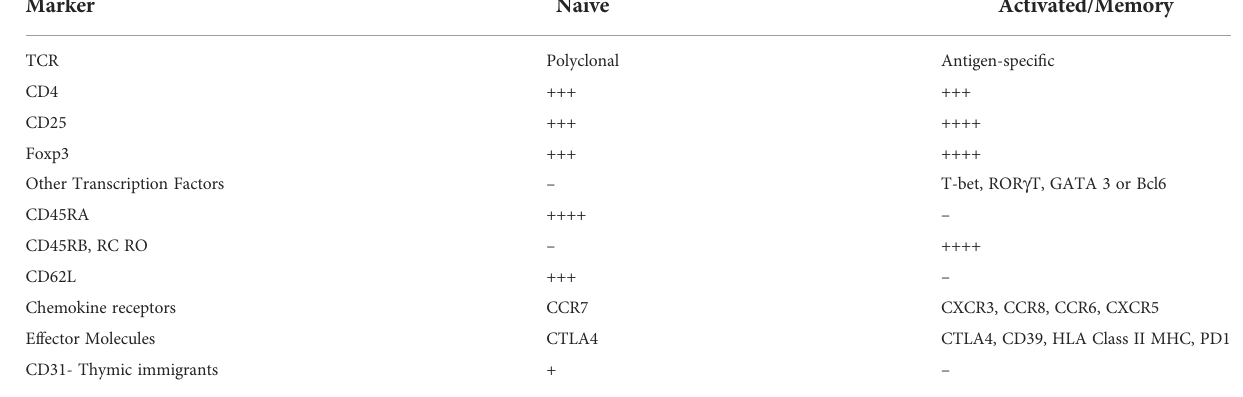
TABLE 1 Markers of Naïve and activated